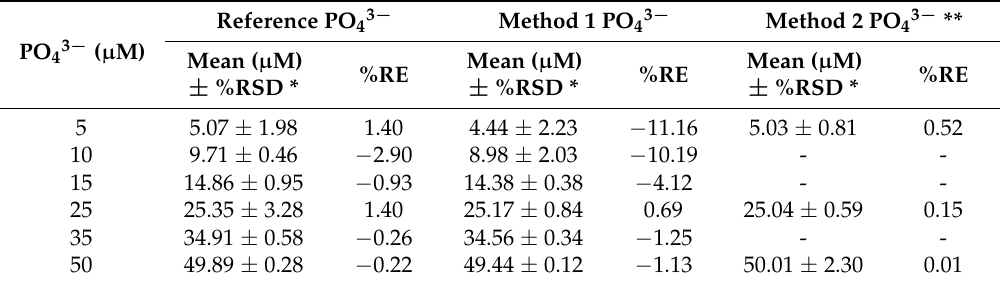
Table 1. Analytical performance of the sensing platform based on data from Figure